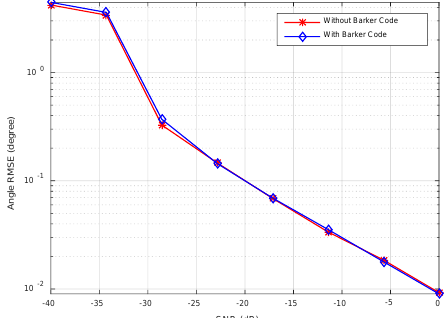
Figure 14. RMSEs versus the SNRs.